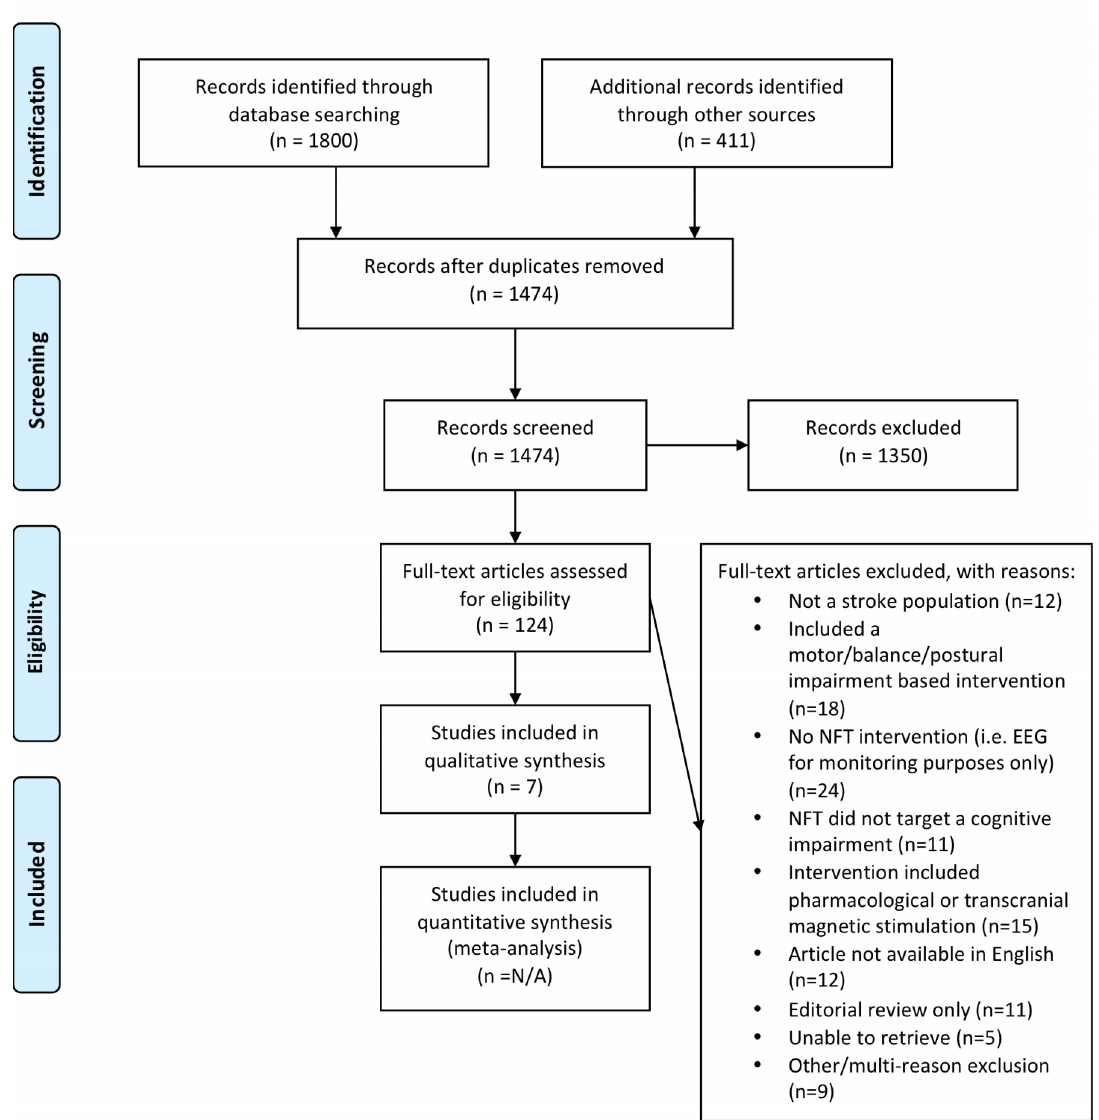
Fig 1. PRISMA flow diagram. Articles identifiedfor inclusionin this review using databases, grey literature and journals. Figure taken from: Moher D, LiberatiA, Tetzlaff J, Altman DG, The PRISMA Group (2009). P referred R eporting I tems